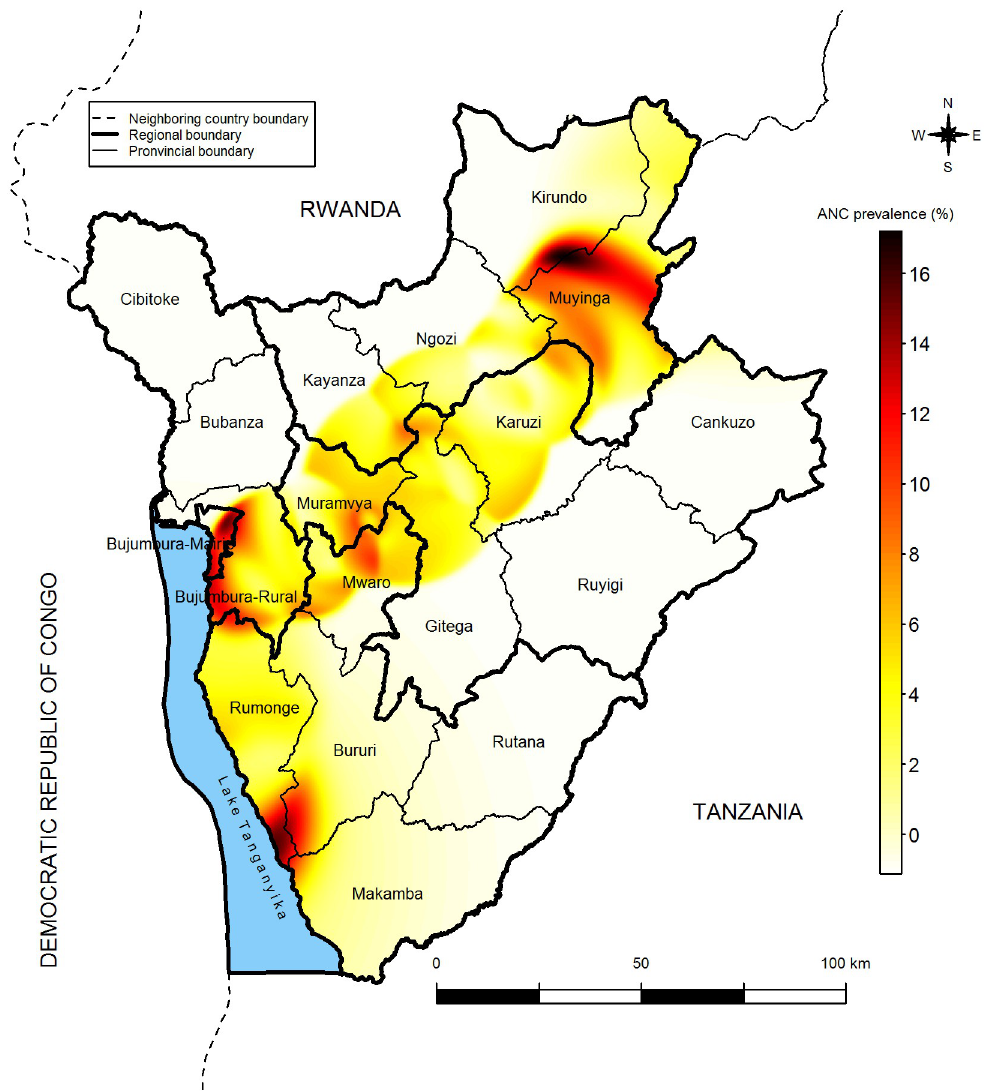
Fig 5. Predicted ANC prevalence in unsampled data